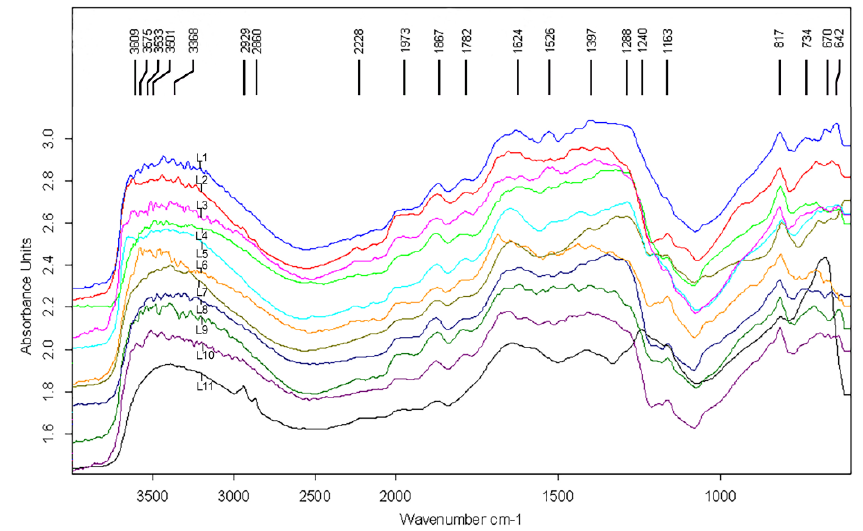
Figure 10. FT-IR spectra of the ceramic fragments from Piatra Neam ț – Lut ă rie. In all analyzed samples, calcite (CaCO 3 ) was identified by peaks at ~2970 cm − 1 , ~2936 cm − 1 , ~2519 cm − 1 , ~737 cm − 1 . In addition, the presence of carbonates [51,52] is visible from the broad band at 1300–1500 cm − 1 , which indicates that the firing tem- peratures of the vessels did not exceed 700–750 ◦ C [51]. At ~706 cm − 1, aragonite was identified [53], the anhydrous variant of calcium carbonate, which was present in five samples (L2, L4, L6, L8,